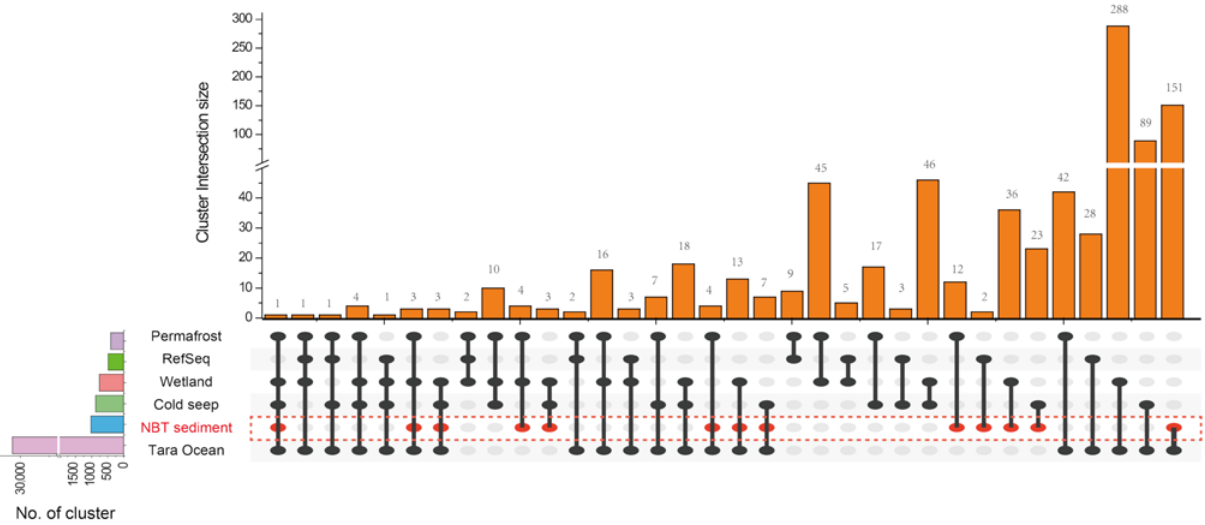
Figure 4. Comparisons to viral sequences from other habitats and data sets. The upset plot shows the comparison of shared viral clusters among four environmental virus data sets (i.e., Tara Ocean seawater, wetland sediment, Stordalen thawing permafrost, Cold seep), Prokaryotic Viral RefSeq, and NBT sediment. Bar size represents the number of viral clusters common to the six sets intersection highlighted using circles below.